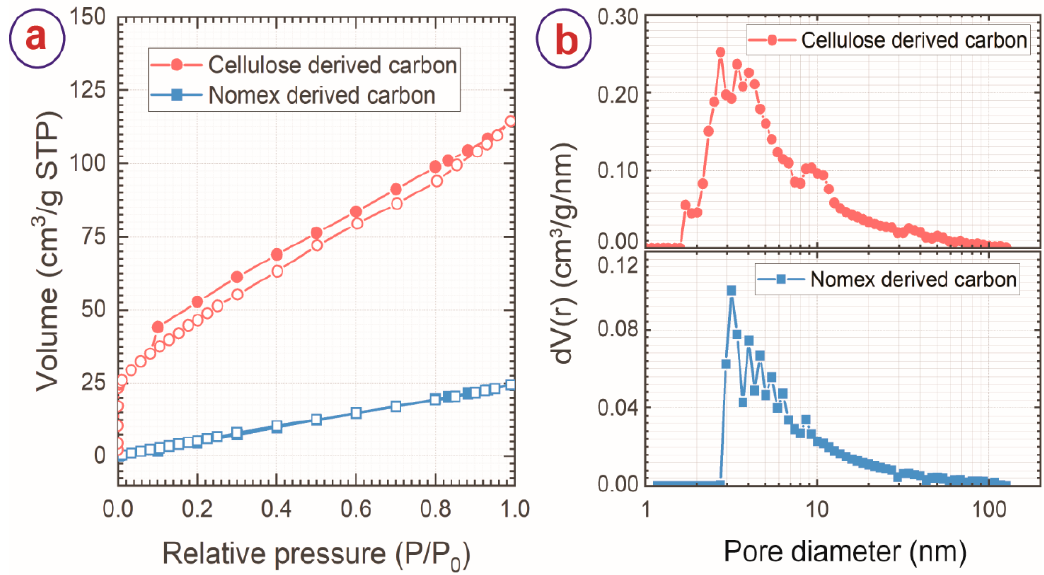
Figure 4. ( a ) Nitrogen adsorption-desorption isotherms and ( b ) pore size distribution of cellulose and Nomex-derived carbon sheets. and Nomex-derived carbon